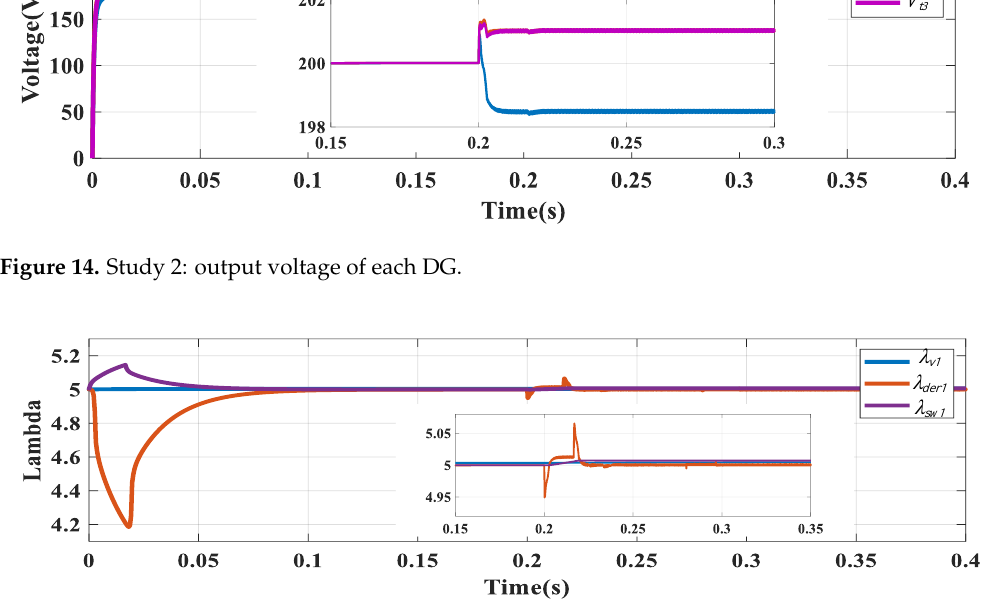
Figure 15. Study 2: generated weighting coefficients for FCS-MPC in DG1.